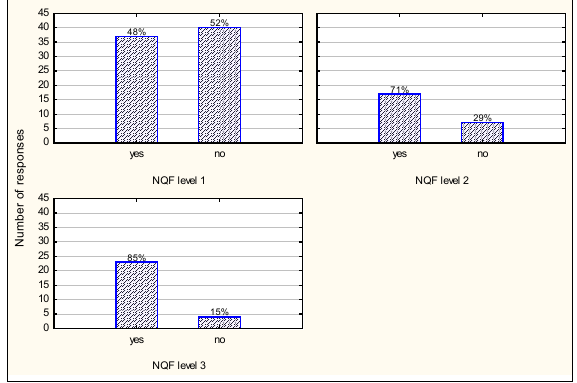
yes, employed; Chi-square test, p = Figure 3: Employment status by NQF level FIGURE 3 Employment status by NQF level